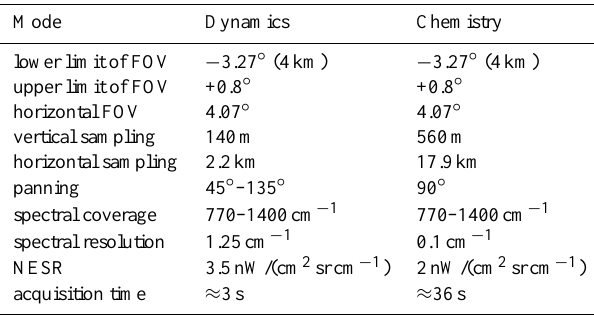
Table 1. This table shows the principal technical characteristics of the GLORIA instrument. The panning angle might be slightly reduced depending on the aircraft onto which GLORIA will be mounted. Both spectral resolution and NESR are given for apodized